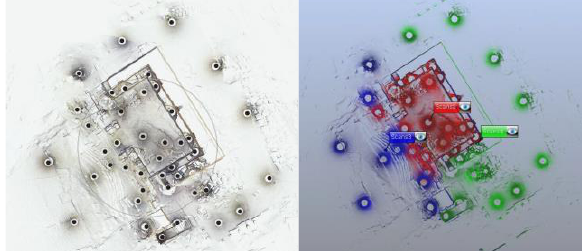
Figure 17. the overall high-quality nymphaeum area UAV cloud in a 3D view with GCPs